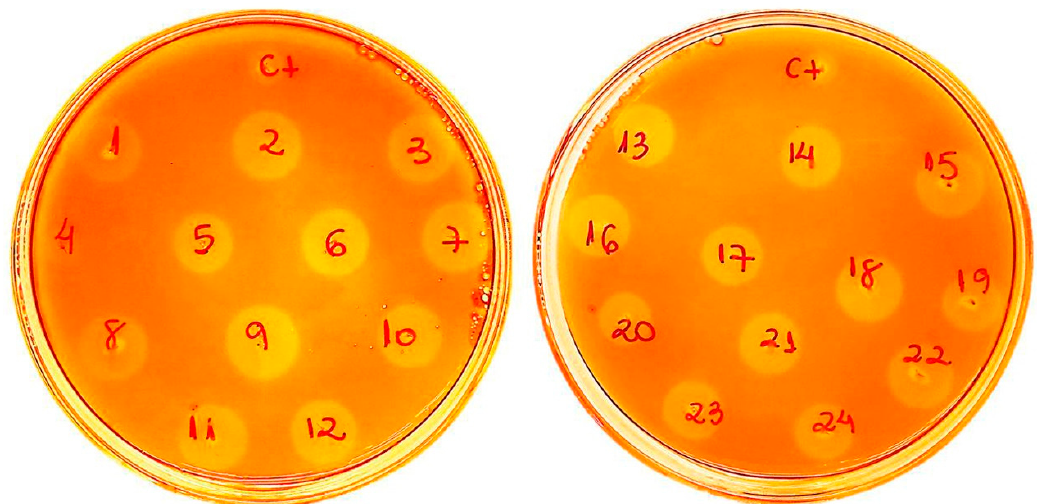
Figure 1. Screening of Af-EGL7 activity in 24 Pichia pastoris transformants on 1% ( w / v ) CM-Cellulose plate after heterologous expression induction with 1% ( v / v ) methanol. The host transformed with empty vector was used as control (ct). Pale orange halos bigger than the control indicated the positive functional colonies.